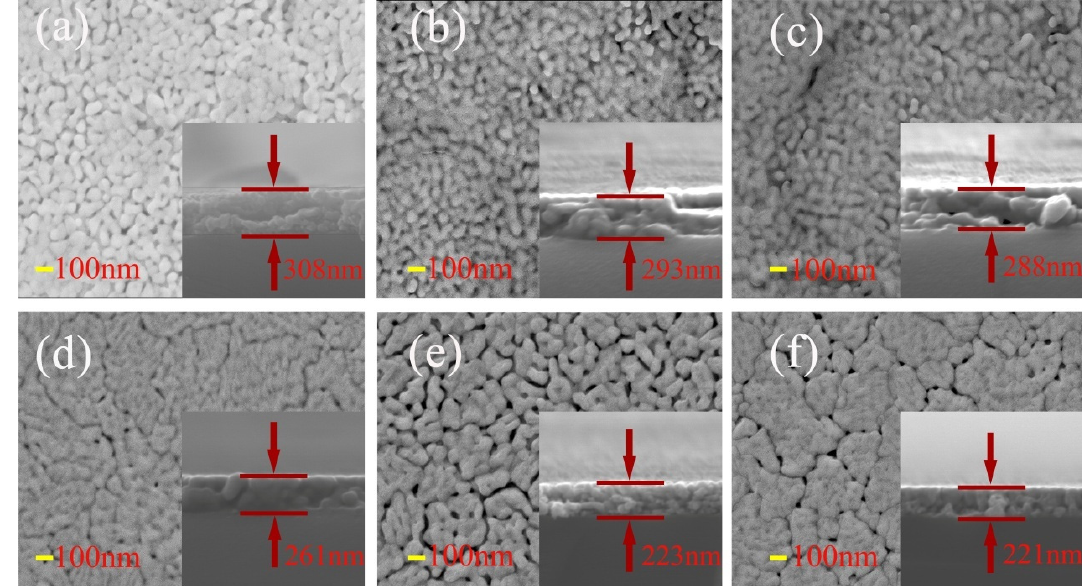
Figure 5. SEM images of surface and cross-sectional morphologies of ( a ) BFO, ( b ) BFC 0.01 O, ( c ) BFC 0.03 O, ( d ) BFC 0.05 O, ( e ) BFC 0.07 O and ( f ) BFC 0.10 O thin films.